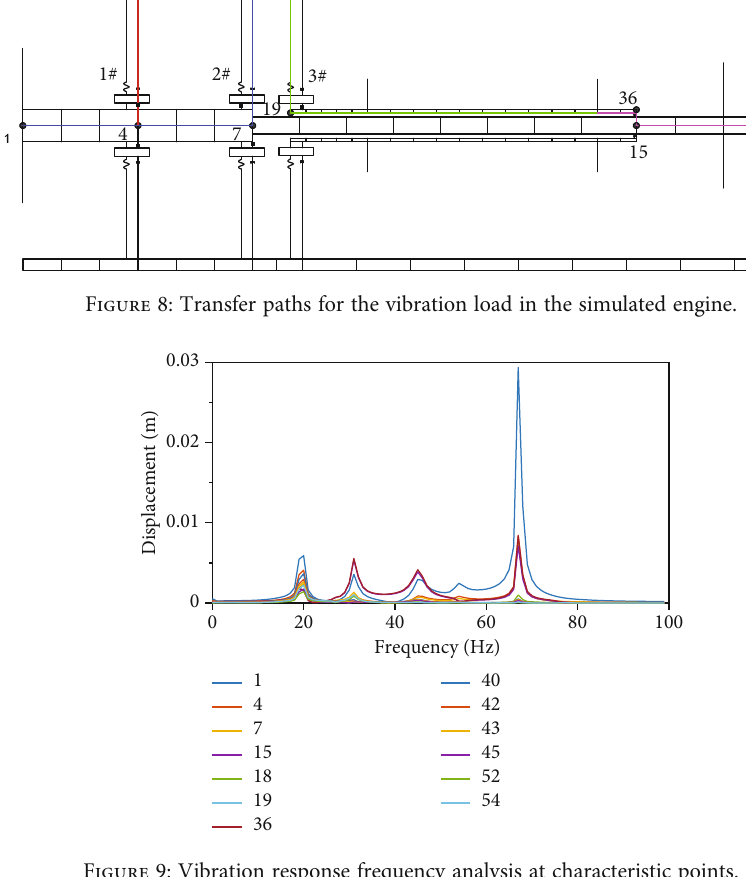
Figure 9: Vibration response frequency analysis at characteristic